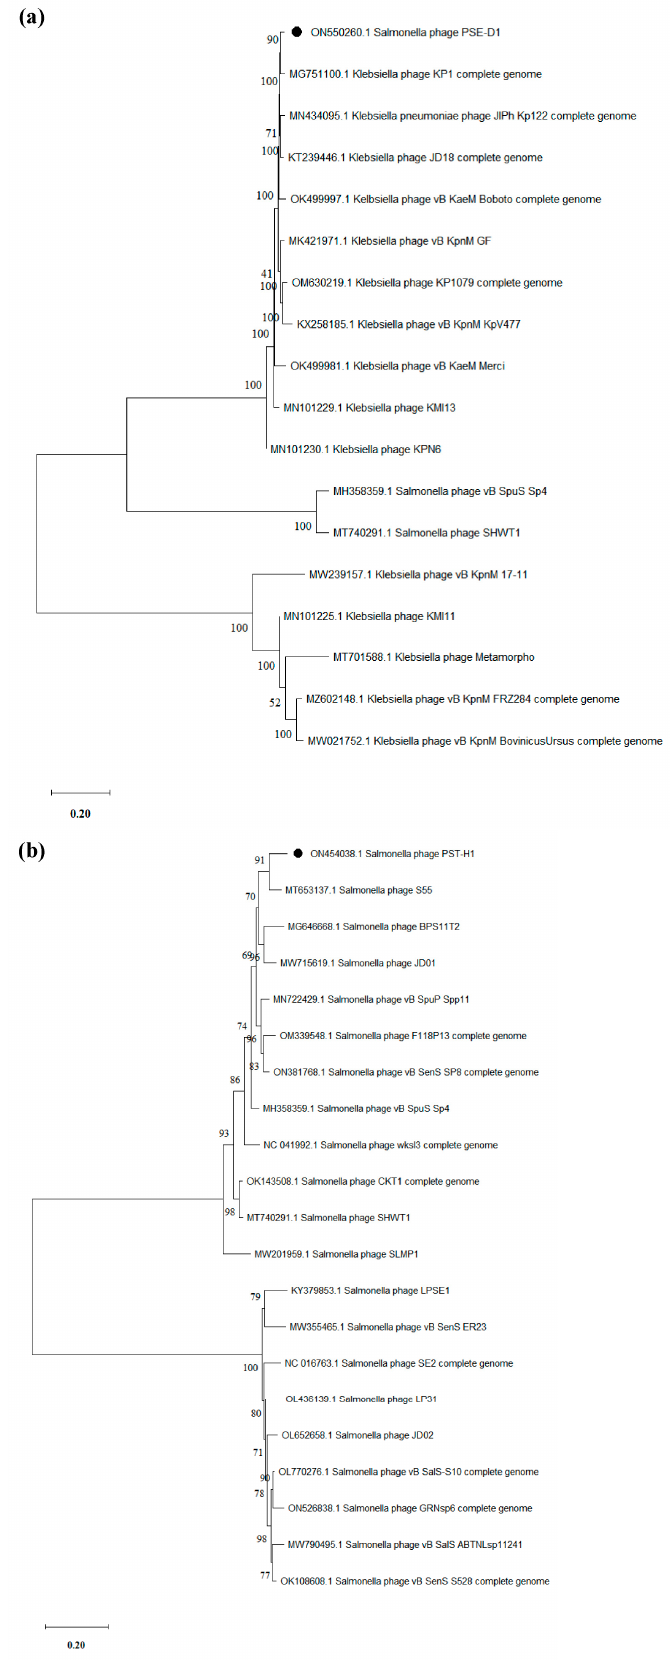
Figure 7. Phylogenetic trees of phages. ( a ) phage PSE-D1. ( b ) phage PST-H1.